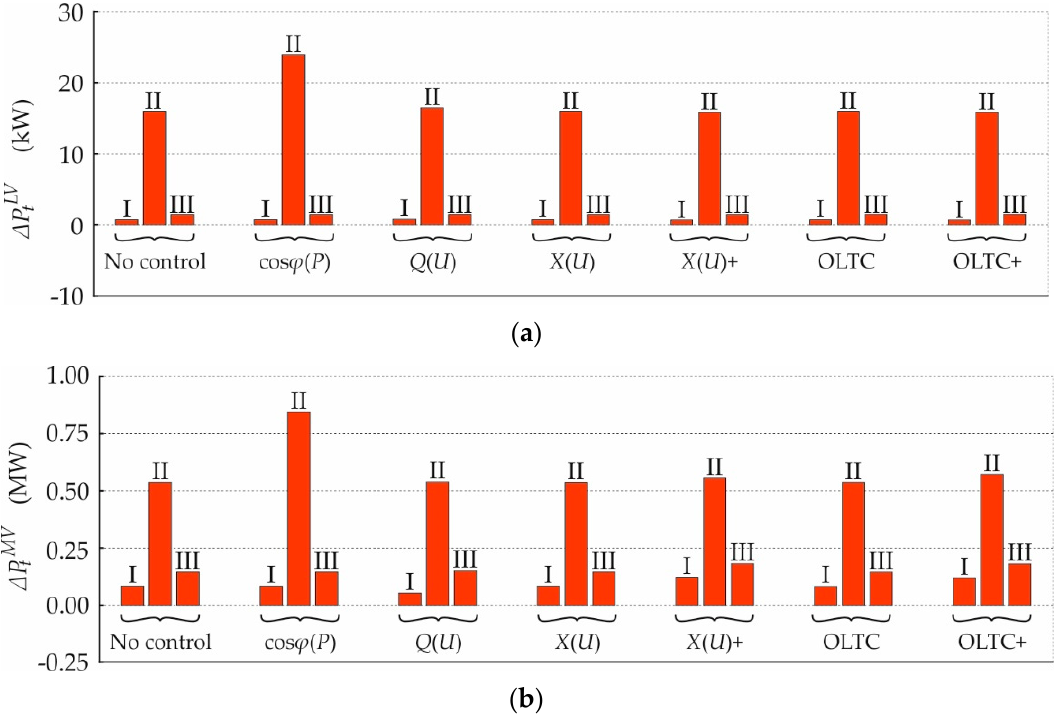
Figure 25. Active power loss for various control strategies and cases within different system levels: ( a ) LV level (rural LV_Link-Grid); ( b ) MV level.